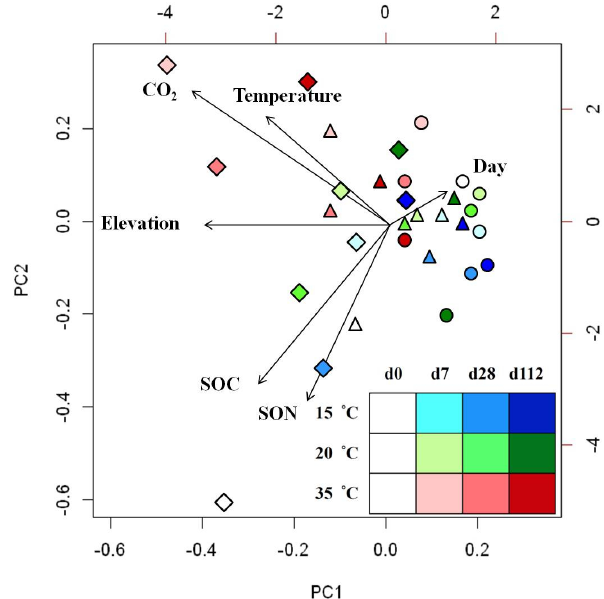
Figure 7. PCA of bamboo soil bacterial communities and environ- mental properties. Symbols are the same as in Fig.